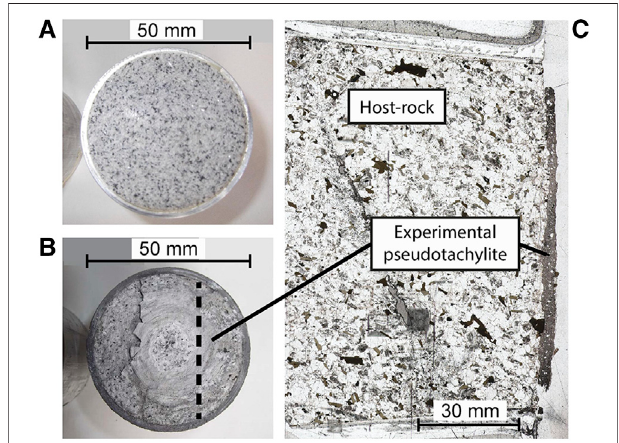
FIGURE 1 | (A) Photography of Westerly Granite cylinder before and (B) after the run. The dotted line represents the location of thin sections cut perpendiculartothecontactsurface. (C) Exampleofathinsectionusedinthis study that contains both host rock and pseudotachylite.